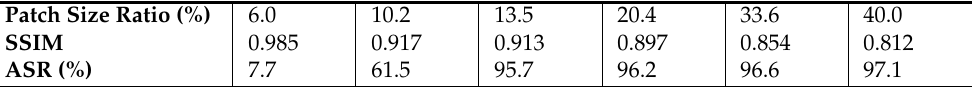
Figure 8. ( a ) is the figure of a clean image without attacked, ( b ) is the figure of our method, ( c ) is the figure of NaturalAE and ( d ) is the figure of [47]. Table 3. The values of corresponding SSIM and attack success rate with the change of patch size ratio. Patch Size Ratio